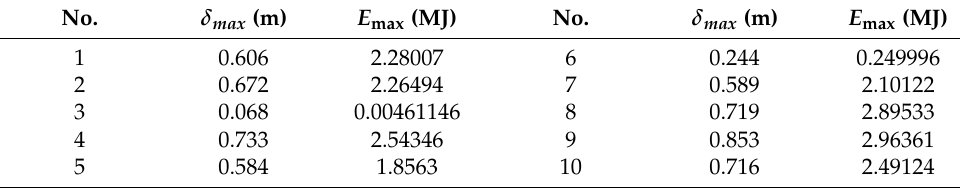
Table 5. Collision response results of testing samples obtained via FEA.